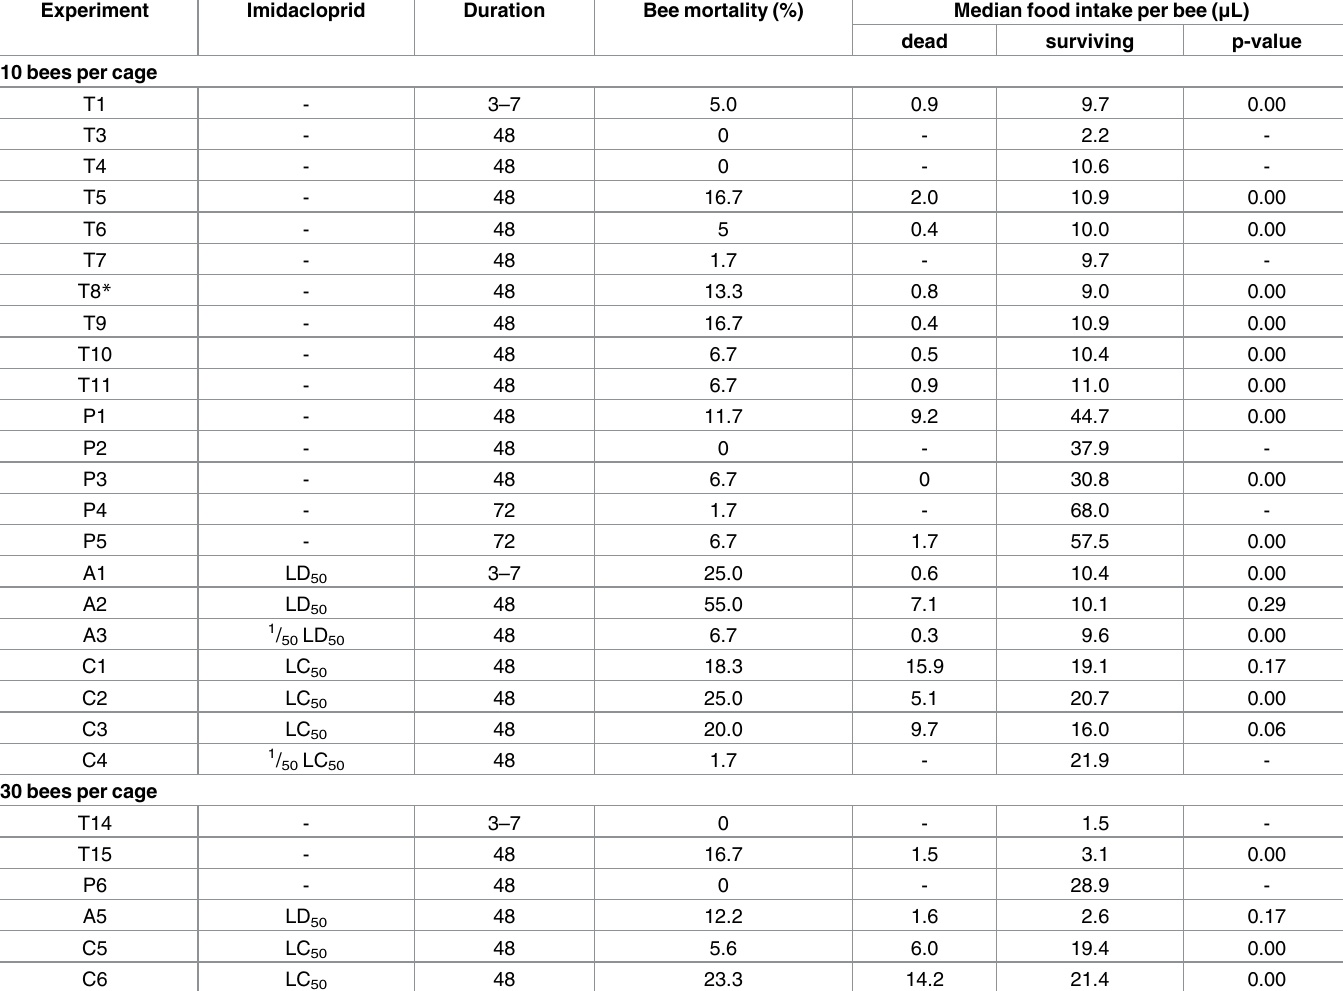
Table 4. Mortality rate and cumulative intake in dead and surviving bees in different experimental setups for temporary 1 (T), acute 2 (A), permanent 3 (P) and chronic 4 (C) feeding regimes. Imidacloprid, durationof experiments, bee mortality, median food intake of dead and surviving bees and the respec- tive p-valuefor the comparisonof medianintake of deadand survivingbees (Mann-Whitney U-test) for all experiments are shown. For numberof replicates see Table 1.